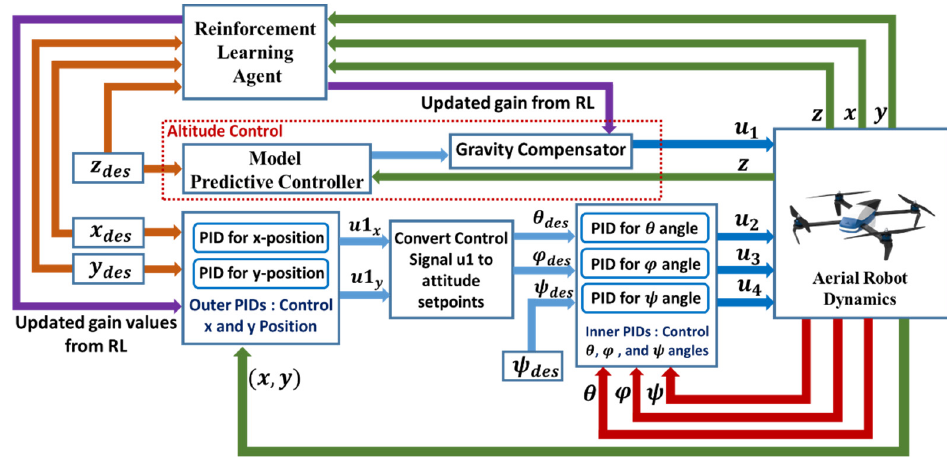
Figure 2. The elements of the proposed control architecture of the quadcopter.